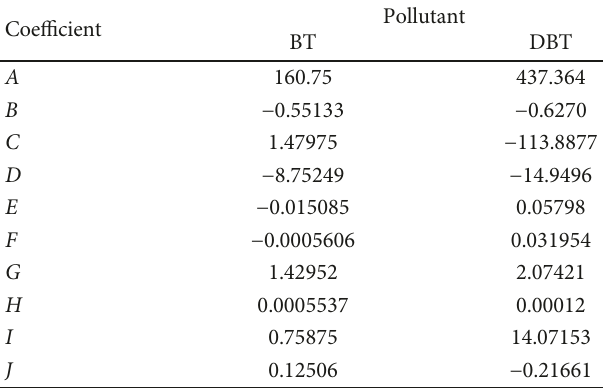
Table 3: Coe ffi cients of